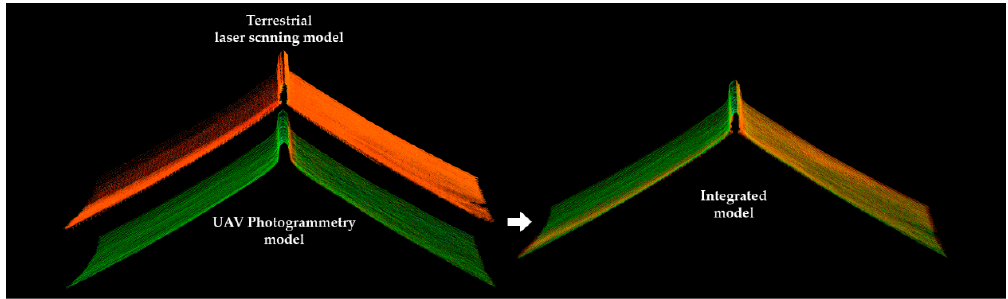
Figure 8. Point clouds showing the roof section of the Daegwangbojeon Hall.